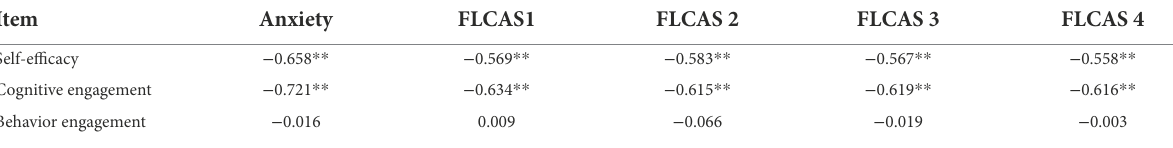
TABLE 3 The correlational relationship between participants’ anxiety and self-efficacy.